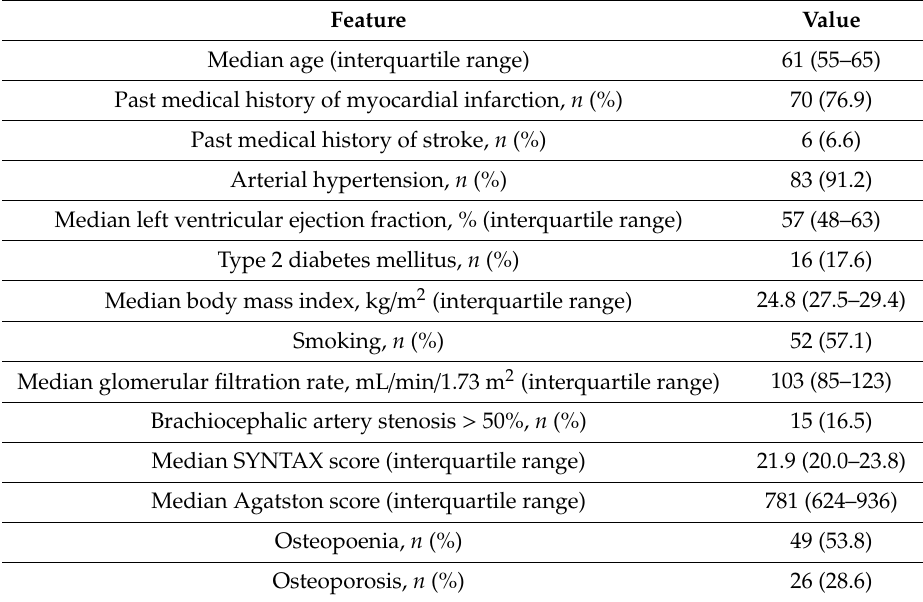
Table 1. Clinicopathological features of the patients ( n = 91).